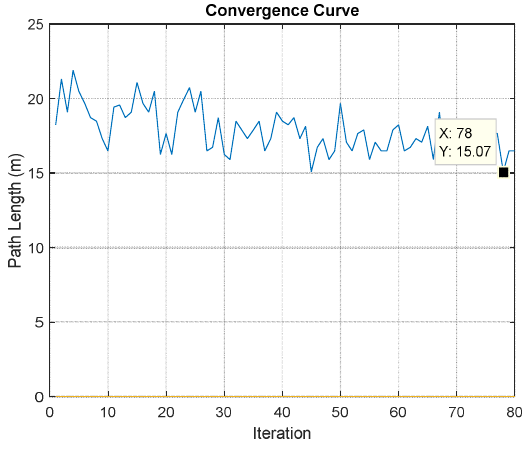
Fig. 11. The Convergence Curve for Experiment 1